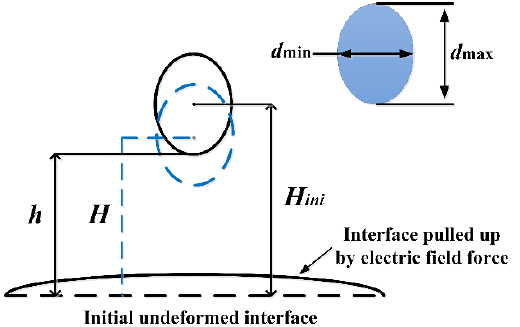
Figure 4. Schematic diagram of parameters extracted from the falling droplet. Between them, d max and d min represent the length of the long axis and the short axis of the droplet, respectively. H / H ini is defined as the dimensionless height of the droplet center, where H and H ini are the real-time distance and the initial distance between the droplet center and the undeformed oil–water interface, respectively, and quantitatively reflect the vertical displacement of the falling droplet. Moreover, h represents the distance between the bottom of the falling droplet and the initial undeformed oil–water interface at the moment the electric field was applied. For droplet–interface coalescence, owing to the asymmetry between the upper and lower agglomerates and the dynamic change in the morphological characteristics of the coalescence droplet, the development of the droplet morphology was difficult to describe. Figure 5 shows the typical morphology of coalesced droplets, where the red dotted line in the figure indicates the liquid bridge area. In this study, the characteristic parameters that define the shape of the droplet include the liquid bridge width, which corresponds to the length of the rectangular structure shown in red dotted line, which is used to describe the expansion and contraction of the liquid bridge in the horizontal direction. The droplet apex height represents the distance from the highest point of droplet to the undeformed oil–water surface, which is used to reflect the change in droplet height in the vertical direction. For more convenient comparative analysis, the instantaneous liquid bridge width and the droplet apex height were kept dimensionless using the diameter and the initial droplet apex height, respectively, which are defined as the dimensionless liquid bridge width ( W liquid bridge width / D ) and the dimensionless droplet apex height ( H vertical length / H initial vertical length ), respectively. Figure 5. Schematic illustration of typical parameters of the droplet shape. 3. Theory Owing to the difference in permittivity, the water droplets in the oil become polarized through the applied electric field to form a dipole. Therefore, the droplets are stretched by the electric field force and become deformed, and the horizontal oil–water interface is also raised slightly upwards by the pulling force of the applied electric field. At the same time, under the action of gravitational force and the electrostatic attraction between the droplet and the interface, the droplet gradually moves to the oil–water